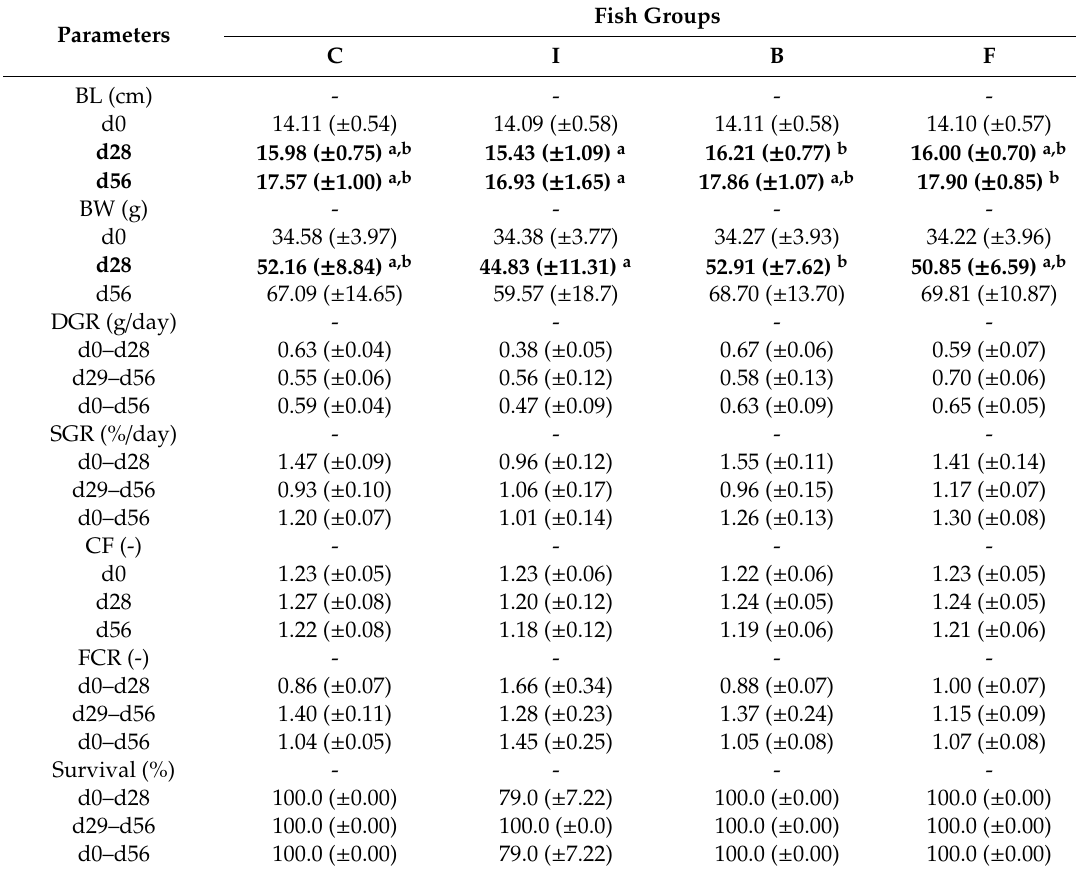
Di ff erent letters in the table point statistical